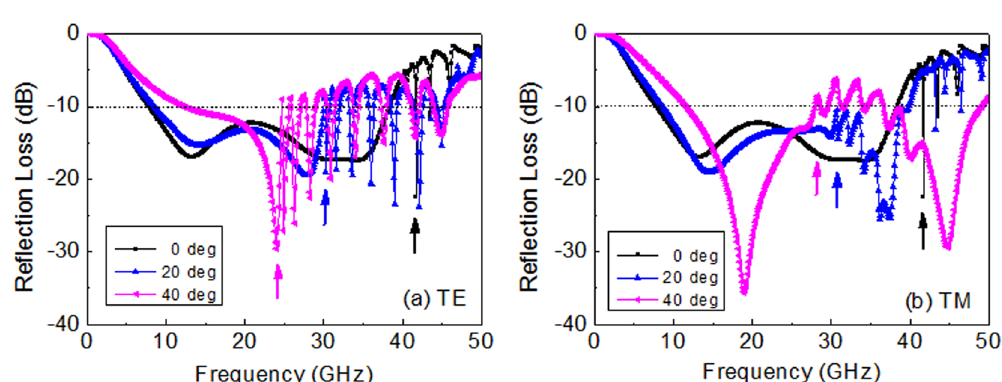
Figure 10. Simulation results of reflection loss of the double-layer FSS absorber with an increasing incidence angle for ( a ) TE and ( b ) TM polarization. The arrows inside the figures indicate the critical frequency at which the grating lobe